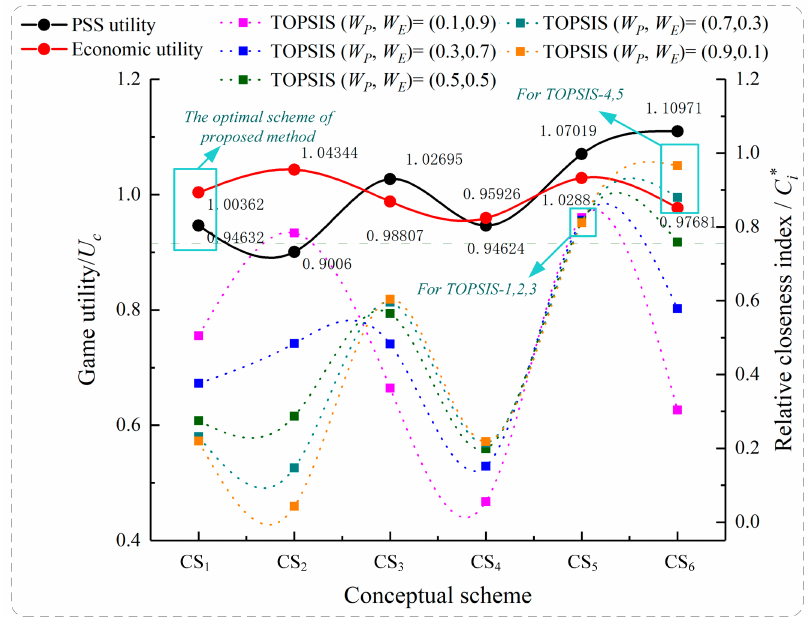
Figure 6. Comparison of game utility results of two decision